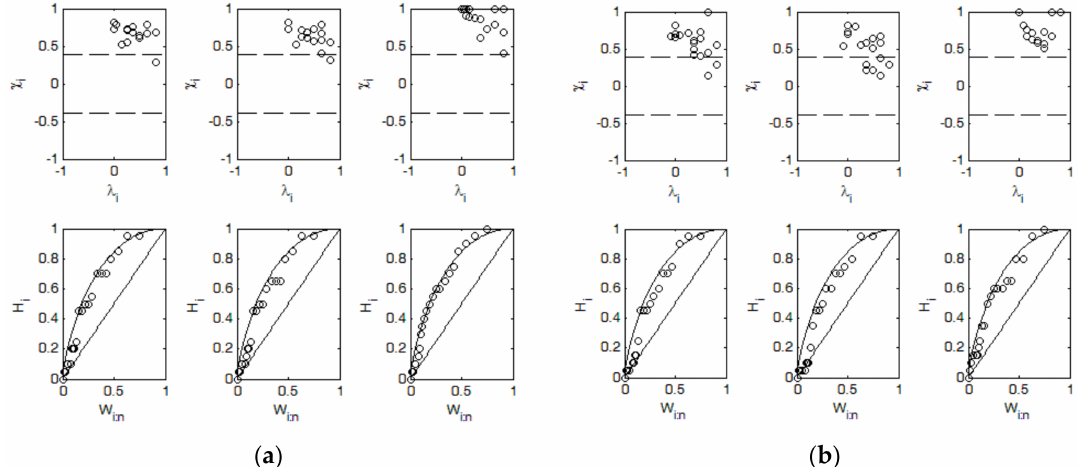
Figure 3. Chi-plots and K-plots of pair-wise flood characteristics for scenarios with and without polders: ( a ) Graphical representation of strength of dependence using chi-plot (upper row) and K-plot (lower row), the pair-wise variables are V & P , V & Z and P & Z from left to right in order without UAPs; ( b ) graphical representation of strength of dependence using chi-plot (upper row) and K-plot (lower row), the pair-wise variables are V & P , V & Z and P & Z from left to right in order with UAPs.